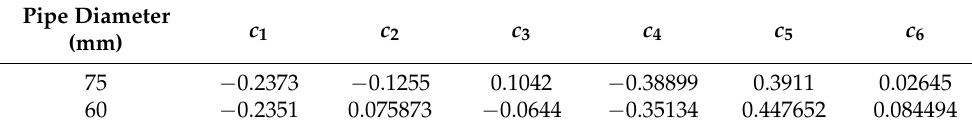
Figure 13. Fitting of the new model when the pipe diameter was 75 mm. The blue line represents the fitted value, and the red line represents the experimental value. The x-axis represents the number of iterations, and the y-axis represents the value of the result. The new empirical constant obtained by fitting and the corrected liquid holdup error are shown in Tables 2 and 3, respectively. Table 2. Parameters of the newly established liquid holdup calculation model.